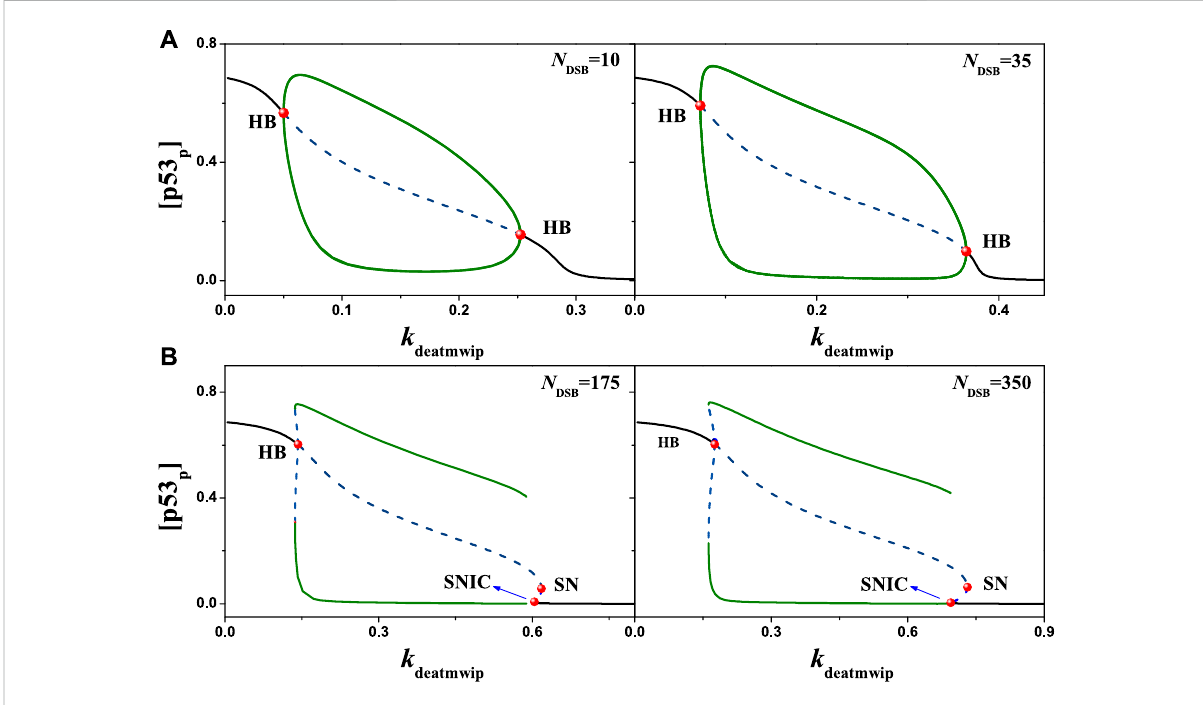
FIGURE 6 Thebifurcationdiagramof[p53 p ]with k deatmwip ,theblacksolidlineanddottedlinerepresentstableandunstablestatesrespectively,thesymbol ‘ HB ’ represents the Hopf bifurcation point, the symbol ‘ SN ’ represents the Saddle-Node bifurcation point, and the symbol ‘ SNIC ’ represents the Saddle Node Homoclinicbifurcationpoint. (A) From leftto right, N dsb = 10 and 35respectively. (B) From leftto right, N dsb = 175and 350respectively. Either in (A) or (B) , the same ordinate system is used for the left and right graphs.